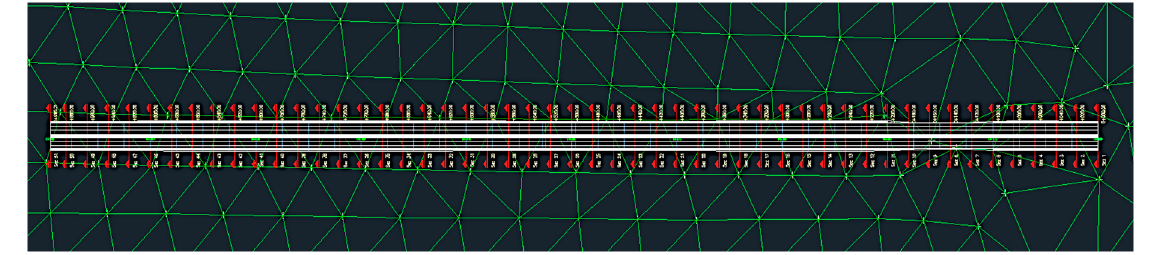
Figure 7. Visualization of the IFC Road model exported from Rhinoceros / VisualARQ in the BIMcollab ZOOM viewer. ( a ) Information about the road divider; ( b ) Material information for the road surface course.